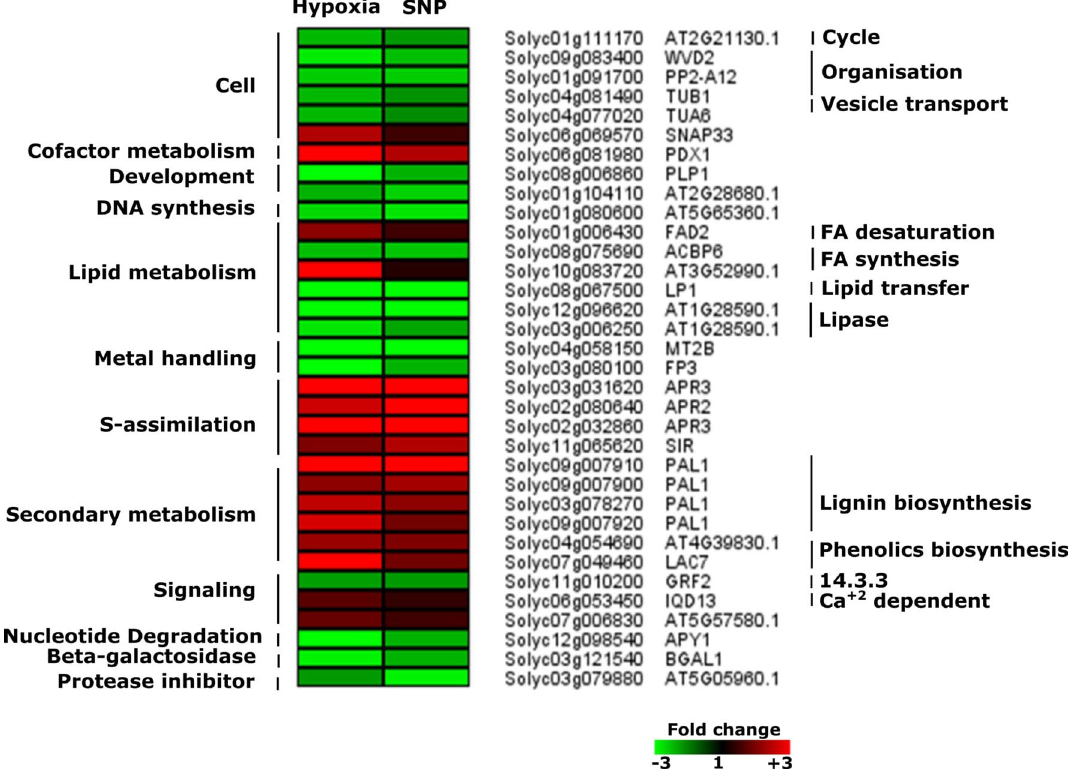
Figure 12. Expression pattern of genes belonging to different biological categories. Heat map represents the up-regulated (red bars) or down-regulated (green bars) tomato genes and their Arabidopsis thaliana homologs in response to hypoxia and SNP-treatment. Depicted are differentially expressed genes ( Padj < 0.05), ( n = 3). WVD2 , WAVE-DAMPENED 2 ; PP2-A12 , PHLOEM PROTEIN 2-A12 , TUB1 , TUBULIN BETA-1 CHAIN ; TUA6 , TUBULIN ALPHA-6 ; SNAP33 , SOLUBLE N-ETHYLMALEIMIDE-SENSITIVE FACTOR ADAPTOR PROTEIN 33 ; PDX1 , PYRIDOXINE BIOSYNTHESIS 1 ; PLP1 , PHOSPHOLIPASE 1 ; FAD2 , FATTY ACID DESATURASE 2 ; ACBP6 , ACYL-COA-BINDING PROTEIN ; LP1 , LIPID TRANSFER PROTEIN 1 ; MT2B , METALLOTHIONEIN 2B ; FP3 , FARNESYLATED PROTEIN 3 ; APR3 , APS REDUCTASE 3 ; APR2 , 5 ′ ADENYLYLPHOSPHOSULFATE REDUCTASE 2 ; SIR , SULFITE REDUCTASE ; PAL1 , PHENYLALANINE AMMONIA-LYASE ; LAC7 , LACCASE 7 ; GRF2 , GENERAL REGULATORY FACTOR 2 ; IQD13 , IQ-DOMAIN 13 ; APY1 , APYRASE 1 ; BGAL1 , BETA GALACTOSIDASE 1